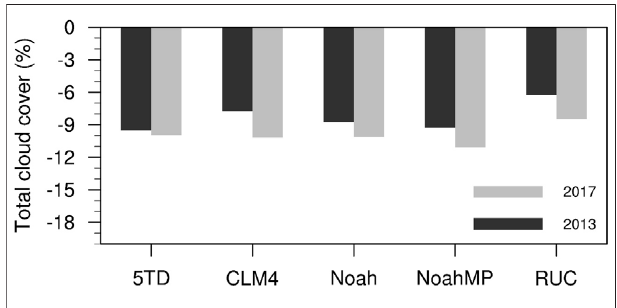
FIGURE 6 | The differences in areal mean total cloud cover over the studyregion(outlinedboxesin Figure2A )betweenthemodelsimulationsand CERES data for the summer of 2013 (black) and 2017